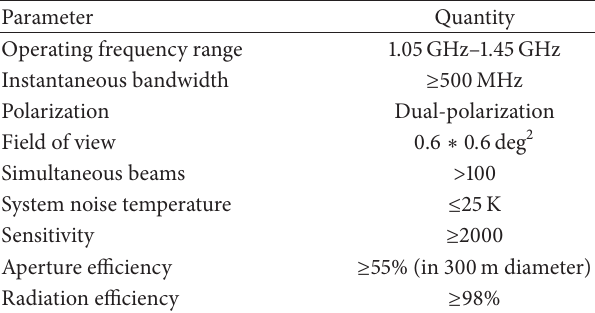
Table 2: Performance specification for L-band